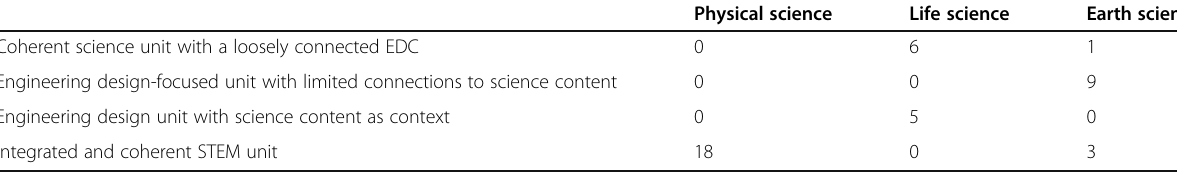
Table 4 STEM units by broad curricular